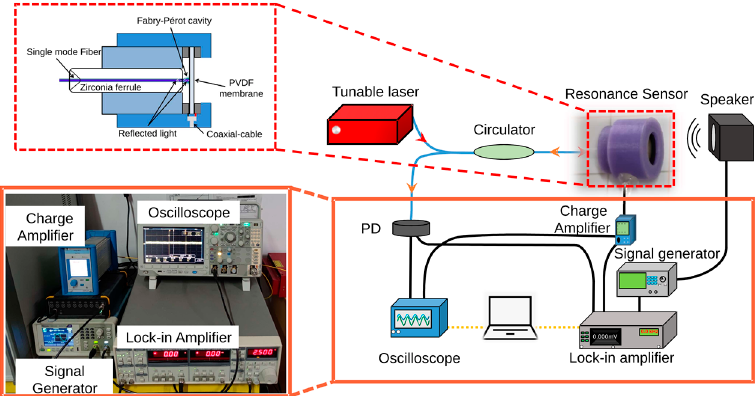
Figure 2. Schemes of the FPI and piezoelectric resonance acoustic detection system.